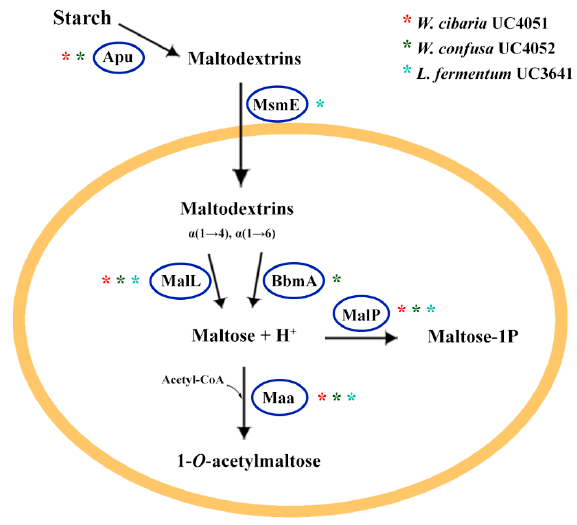
Figure 2. Schematic representation describing starch degradation operated by the three strains selected as starters for sorghum sourdough fermentation.